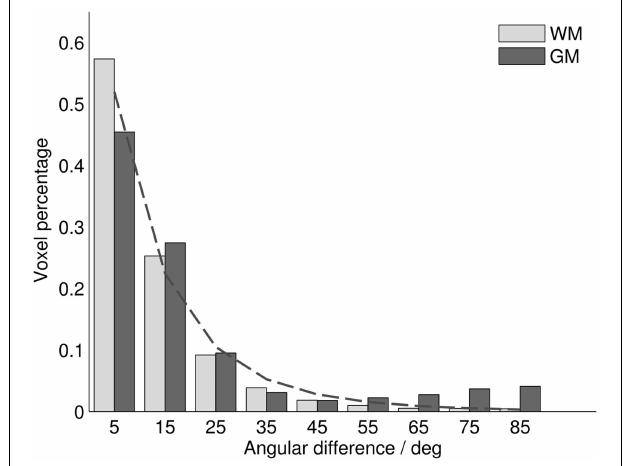
FIGURE 2 | Histogram of angular differences between MRI DT and Hist ST orientations over all analyzed voxels for white and gray matter. Dashed line: Histogram fit with generalized Pareto